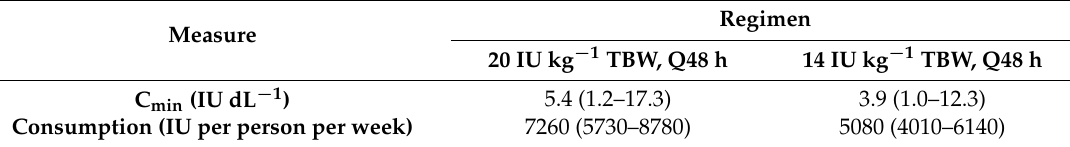
Table 2. Comparison of the typical 20 IU kg − 1 total body weight (TBW) dose and the lowest dose meeting the safety threshold (i.e., 14 IU kg − 1 TBW) in overweight and obese patients. Results are presented as median (90% confidence interval).